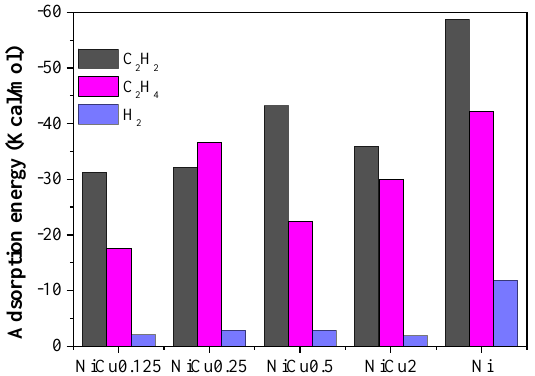
Figure 6. Adsorption energy of C 2 H 2 and C 2 H 4 on the different catalysts.